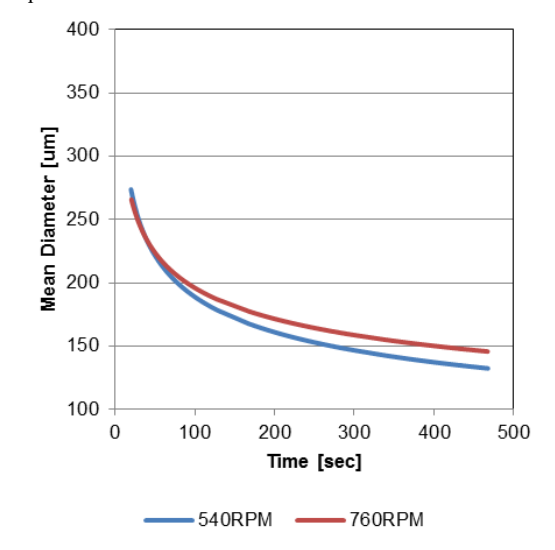
Fig. 5. Interpolated curves for Mean Particle Diameter time dependence of Silicone Oil